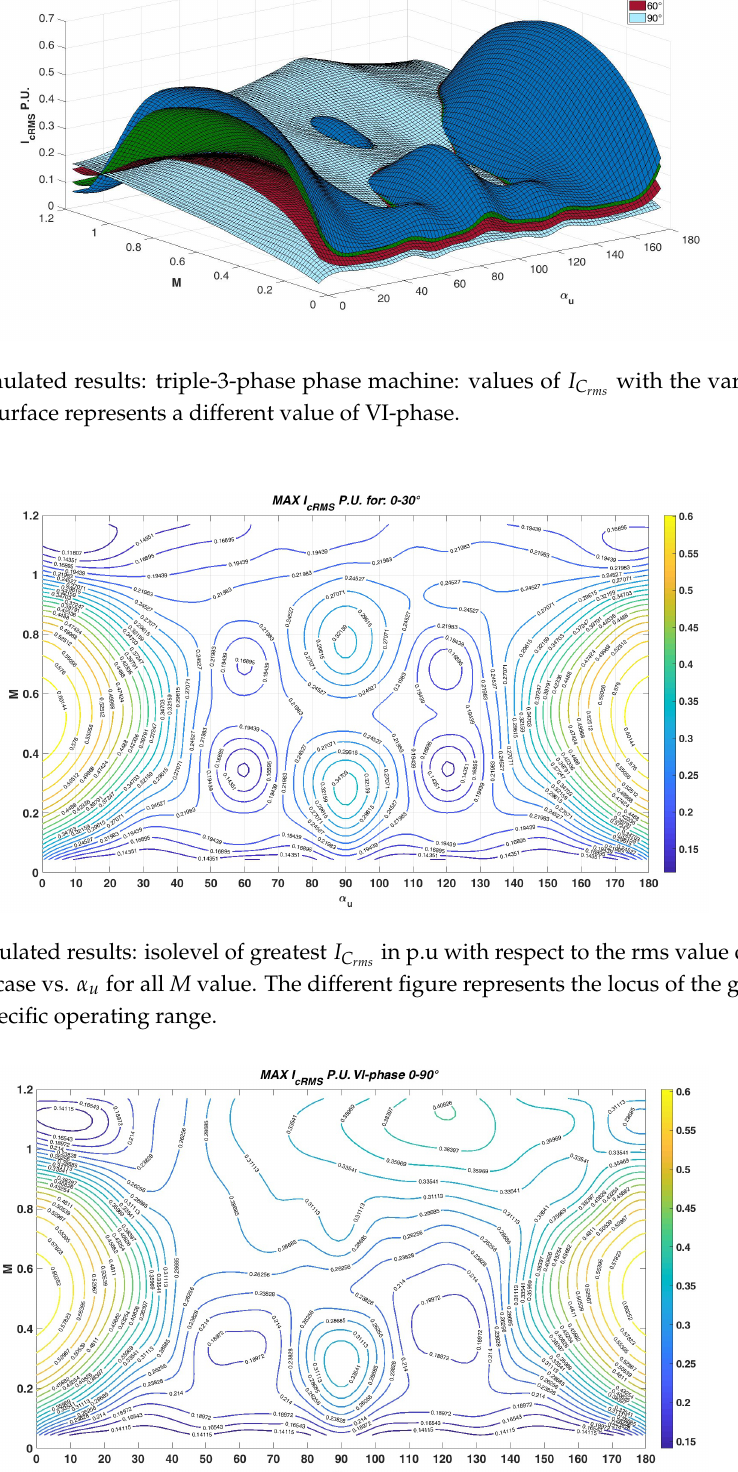
Figure 12. Simulated results: Isolevel of greatest I C current worst case vs. α u for all M value. The different figure represent the locus of the greatest I C values for a specific operating